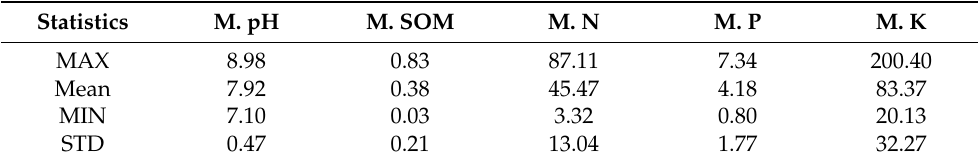
Table 3. Statistics of measured SFC parameters.